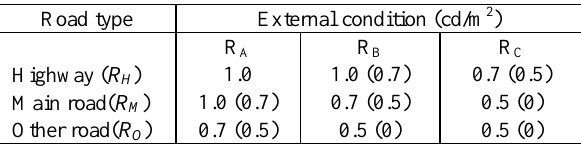
Table 1. Average luminance of road surface in Japan